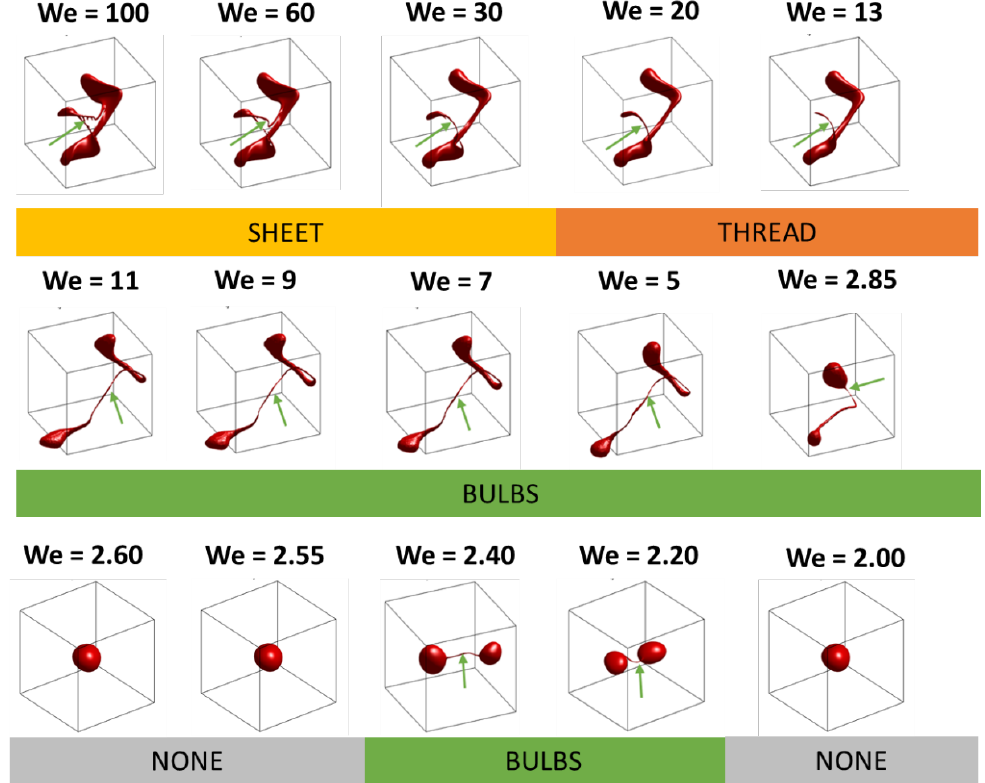
Figure 5. Morphology at initial breakup as a function of Weber number for in intermediary viscosity drop ( µ D / µ C = 22). Green arrows show the point of initial detachment.